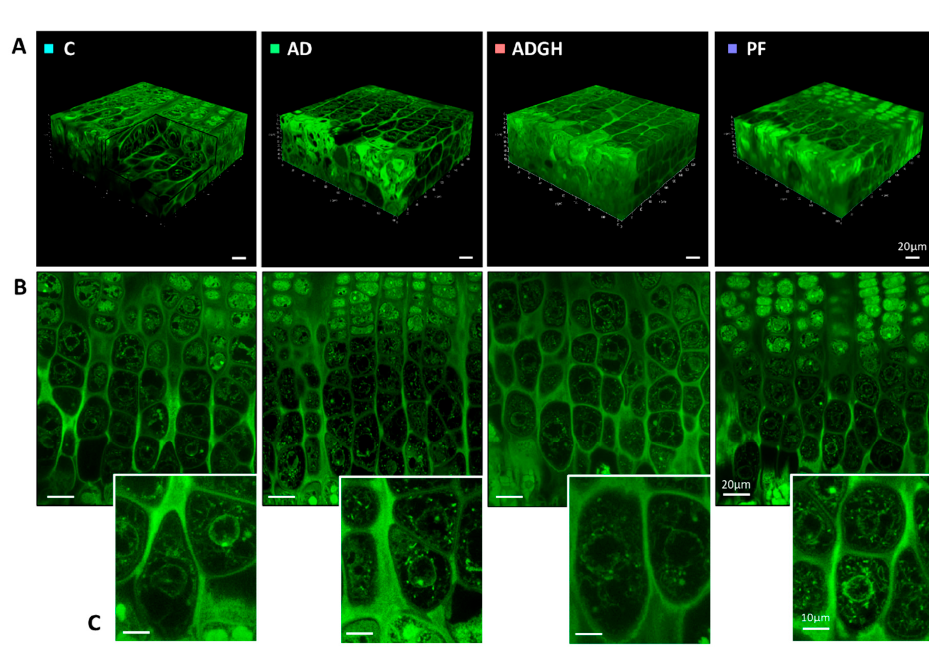
Table 2. Growth parameters in the groups of rats ( n ≥ 5 per group).